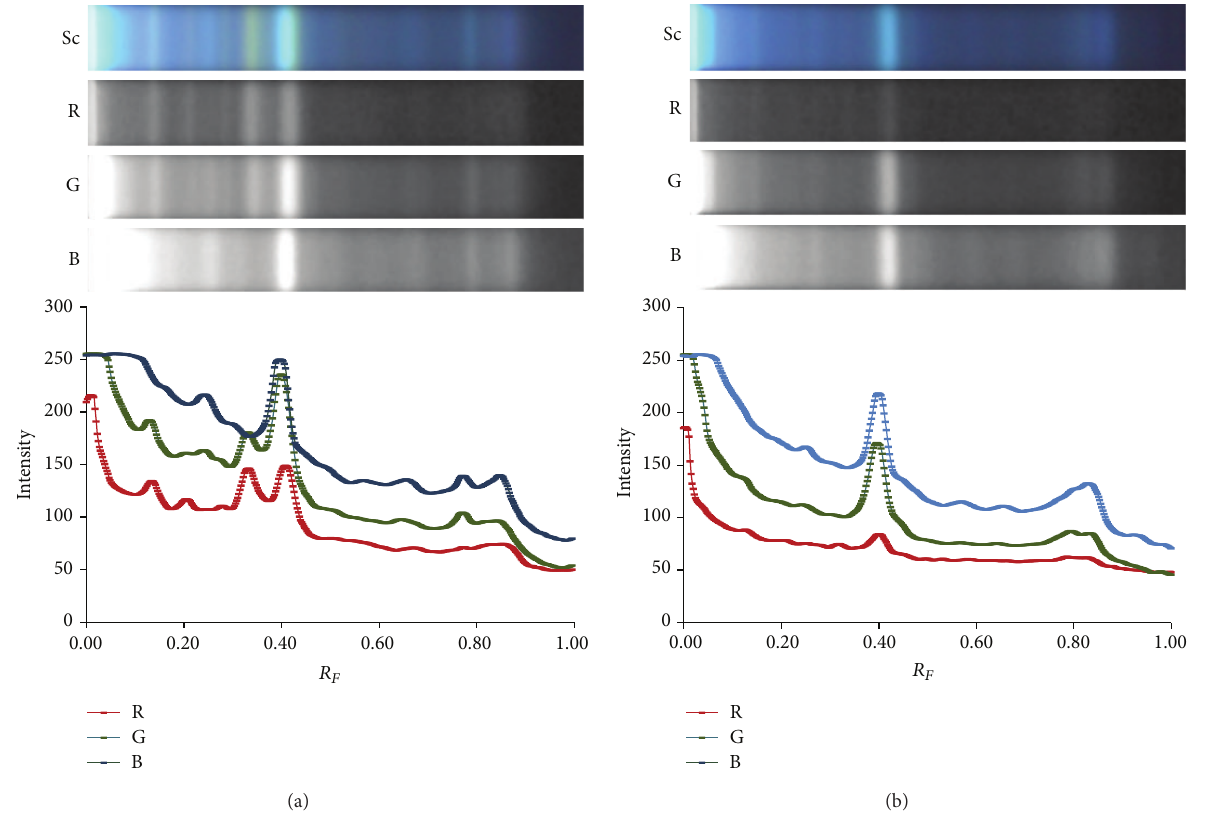
Figure 2: The line profile plots of chromatograms of shoot control samples of ZP 434 (a) and ZP 704 (b) hybrids obtained in CS2 and split through RGB channels (R: red, G: green, and B: blue). Labels on score plot correspond to those in Table